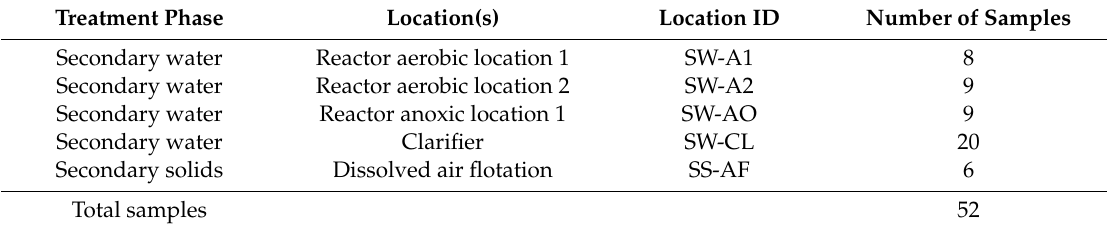
Table 2. Process locations for flotation samples that were collected during this study (using the flux chamber approach according to AS / NZS 4323.4:2009 [30]).